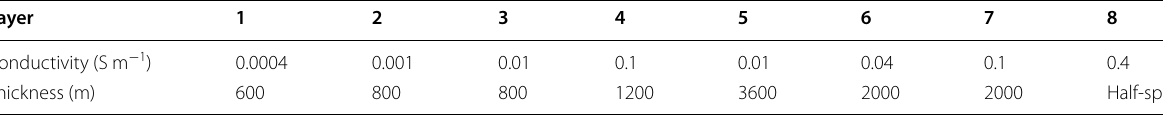
Table 1 The true parameters of the eight-layer model